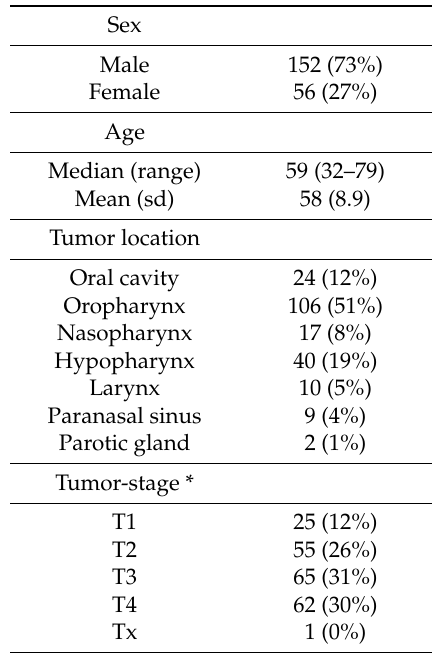
Table 1. Patient characteristics (High Dose CCRT N = 208).